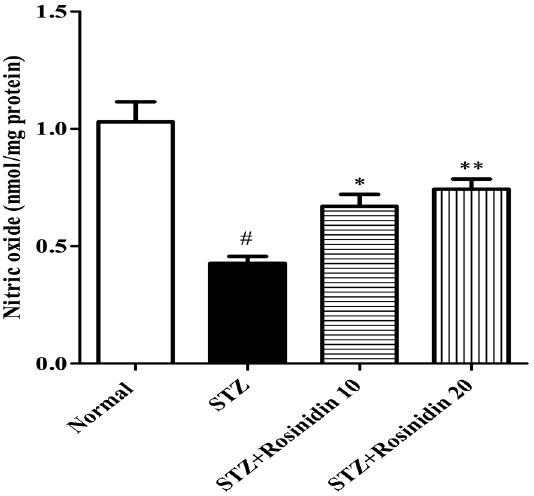
Figure 6. The effect of rosinidin on nitric oxide level. All the values are presented as the mean ± SEM. Correlation among the groups was done using Tukey’s test by one-way ANOVA. p -value < 0.05, 0.01 were expressed as *, ** respectively as compared with the streptozotocin (STZ) group. # significant as compared with the controls ( p < 0.001).